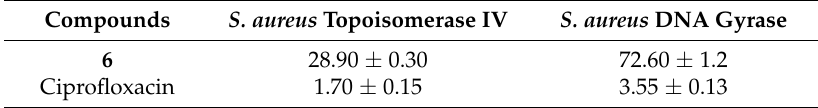
Table 4. Inhibitory activities against DNA topoisomerase IV and DNA gyrase, expressed as IC 50 ± SEM ( µ